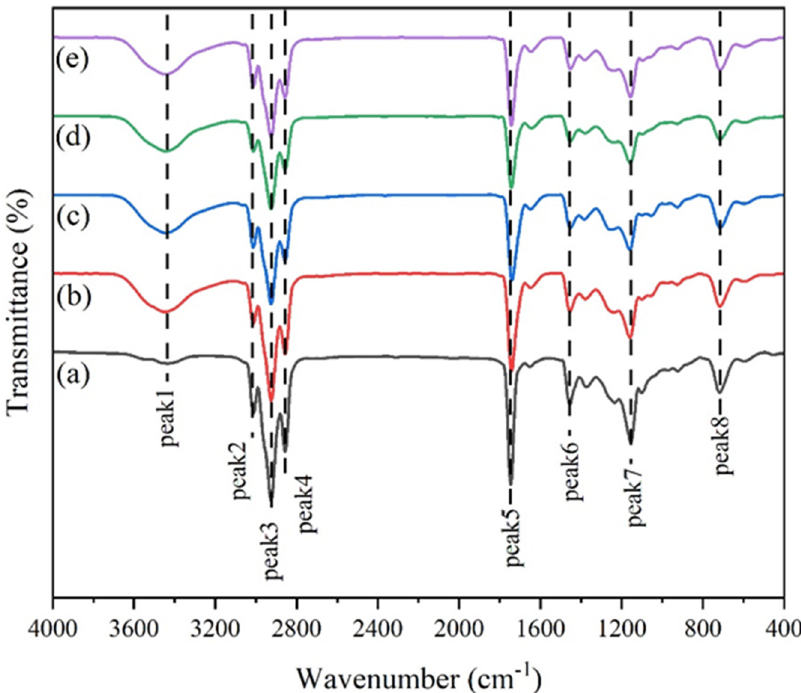
Figure 1. FITR spectra of tuna oil and its hydrolyzed acylglycerols: ( a ) Tuna oil; ( b ) TL 100 L − 30%; ( c ) TL 100 L − 60%; ( d ) ADL − 30%; ( e ) ADL − 60%. ( c ) TL 100 L − 60%; ( d ) ADL − 30%; ( e ) ADL − 60%. Table 2. Eight characteristic peaks of tuna oil and its hydrolyzed acylglycerols.